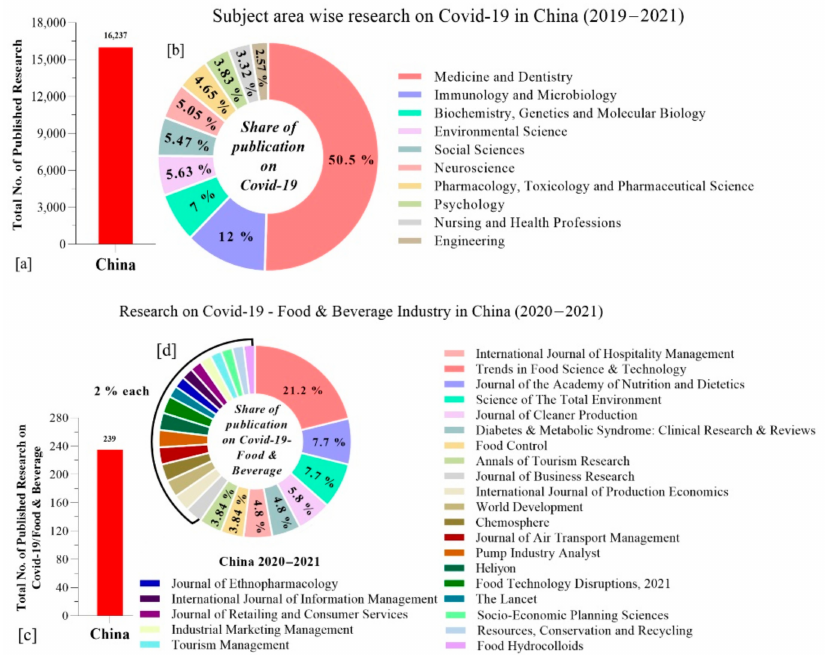
Figure 2. ( a ) Total number of published research studies on COVID-19; ( b ) subject area specific research on COVID-19 in China (2019–2021); ( c ) total no. of research studies and ( d )